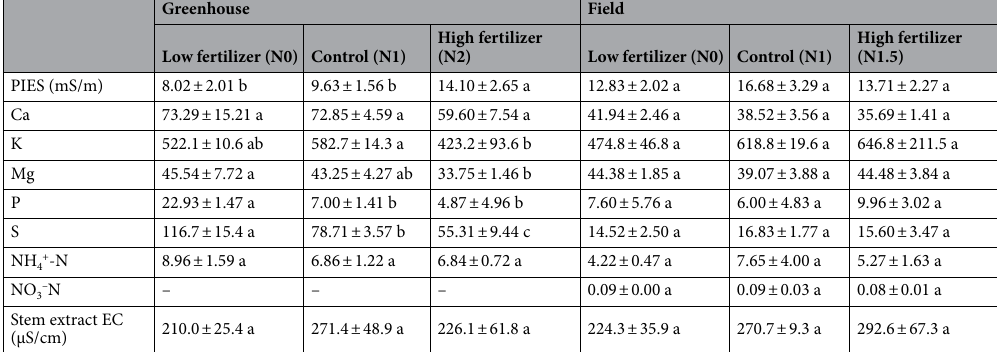
Table 2. PIES and nutrient concentrations of pepper stem extract (mg/kg). Significant differences among different treatment groups were marked with different letters ( p < 0.05).